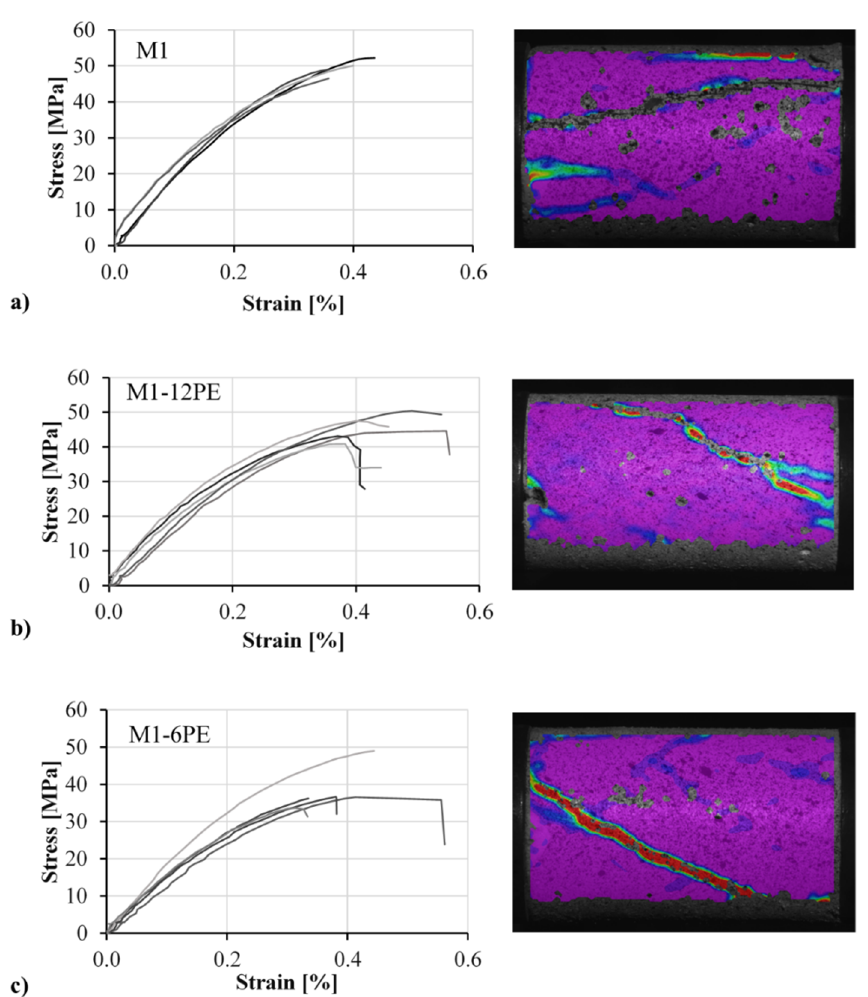
Figure 6. Stress-strain curves and corresponding typical failure modes (digital image correlation (DIC) images) of specimens obtained under quasi-static loading for the mixtures: ( a ) M1, ( b ) M1-12PE, and ( c ) M1-6PE. The specimen’s length was 80 mm, and the diameter was 50 mm.